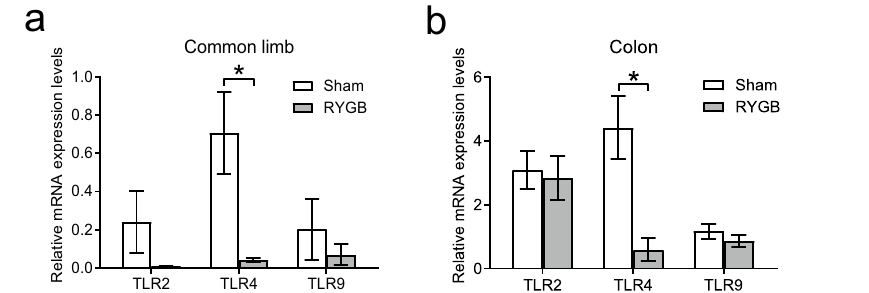
Figure 3. RYGB suppressed systemic and intestinal inflammation. ( a – c ) Compared to those in the sham group ( n = 6/group), levels of plasma inflammatory cytokines, such as LPS, IL6, and TNFα, were notably decreased in the RYGB group ( n = 5/group). ( d , e ) The mRNA levels of inflammatory cytokines in the common limb and colon were determined by quantitative real-time PCR. Compared to the sham group, gut inflammation was reduced after RYGB surgery. TNFα tumor necrosis factor-α, IL6 interleukin-6, IL1β interleukin-1β, LPS lipopolysaccharide. All data are the mean ± SEM. * p < 0.05; ** p < 0.01.